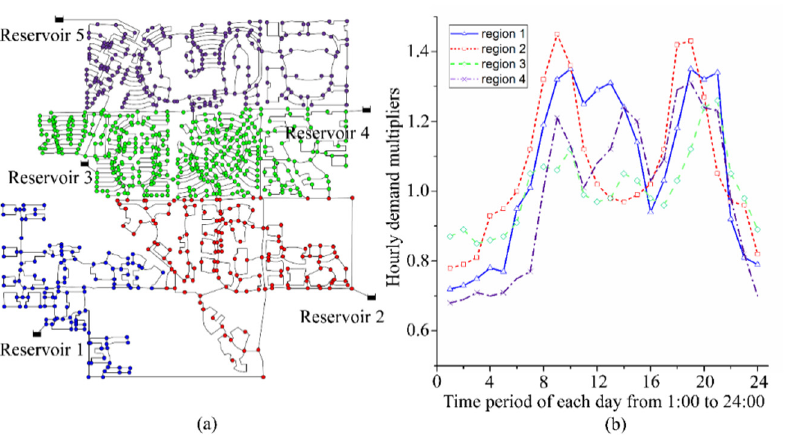
Figure 1. ( a ) The layout of the studied WDS, with the blue, red, green and purple nodes representing supply regions 1, 2, 3 and 4 for different nodal demand patterns, respectively. ( b ) The hourly demand multipliers for supply regions 1, 2, 3 and 4.